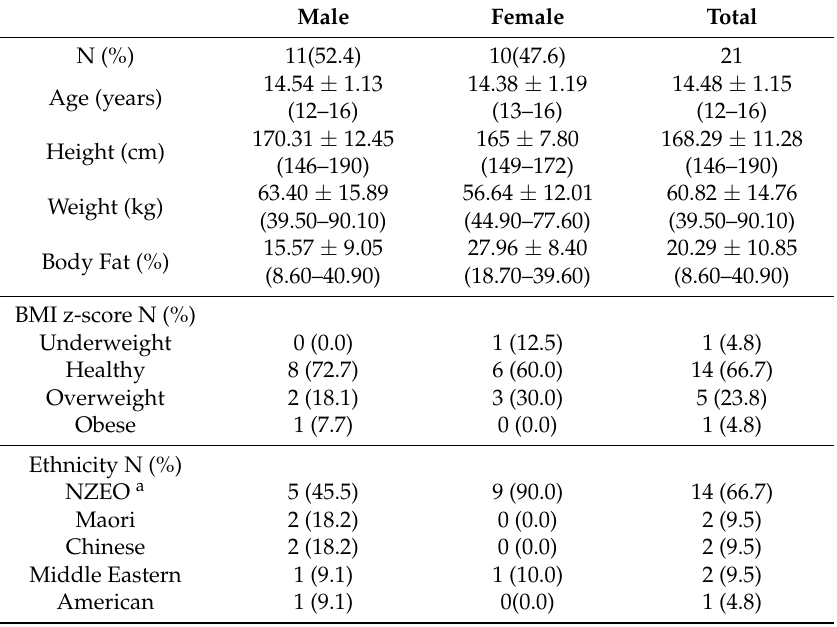
Table 1. Participant characteristics; mean ± SD